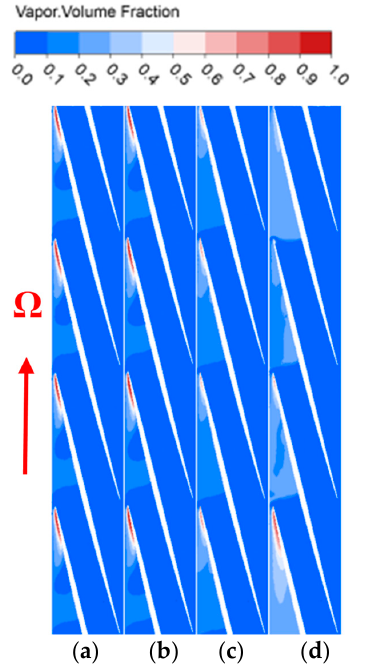
Figure 9. VVF distribution at 0.5 times blade height in impeller passage under critical cavitation condition ( Δ = 3%): ( a ) ν = 24.46 mm 2 /s; ( b ) ν = 48.48 mm 2 /s; ( c ) ν = 60.70 mm 2 /s; ( d ) ν = 120.0 mm 2 /s.